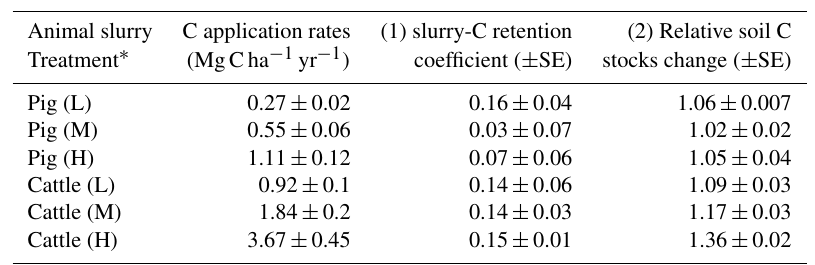
Table 1. Effects of C application rates of different animal slurries to soils on (1) slurry-C-retention coefficient, and on (2) relative soil C stocks change. The slurry-C-retention coefficient represents the average proportion of slurry-C, which has been annually retained in soils after 43 years of slurry applications. The relative soil C stocks change is the ratio between SOC stocks in plots receiving slurry and SOC stocks in plots receiving mineral (i.e. NPK) fertilization (sensu Maillard and Angers, 2014). Standard errors indicate variation among six replicate values for each